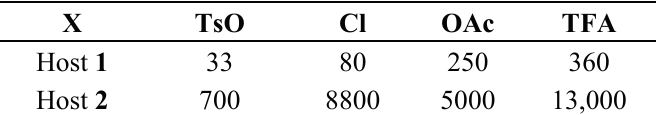
Figure 8. Association constants K as (M − 1 ) of 1:1 complexes of tetramethylammonium salts Me 4 N + ·X − with hosts 1 and 2 in CDCl 3 , in presence of tosylate, chloride, acetate or trifluoroacetate anions [30].